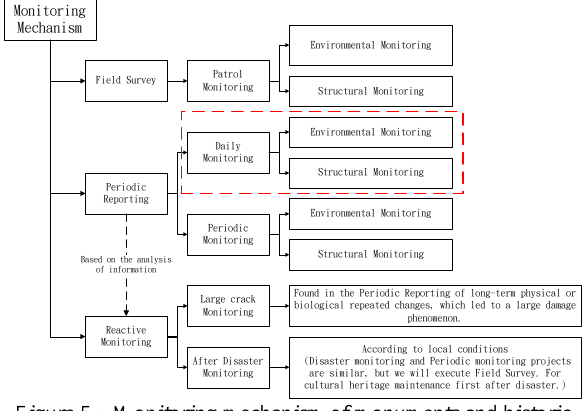
Figure 5 、 Monitoring mechanism of monuments and historic